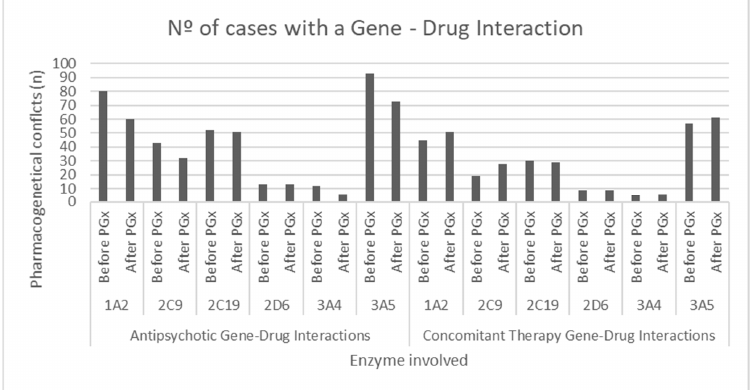
Figure 3. Number of conflicts between the patients’ genotype and the prescribed pharmacotherapy associated with each member of the CYP450 system studied. PGx: Pharmacogenetic Analysis